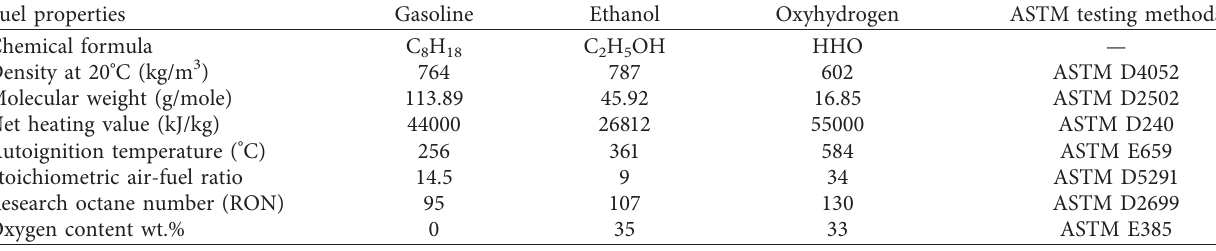
Table 2: Properties of gasoline, ethanol, and oxyhydrogen.